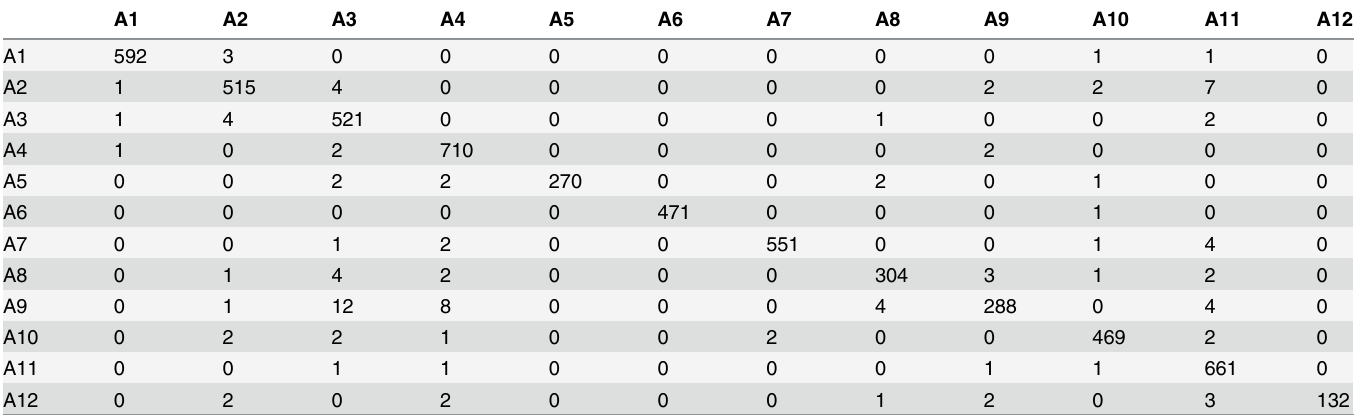
Table 11. Confusion matrix for KNN classifier on features set FS5.